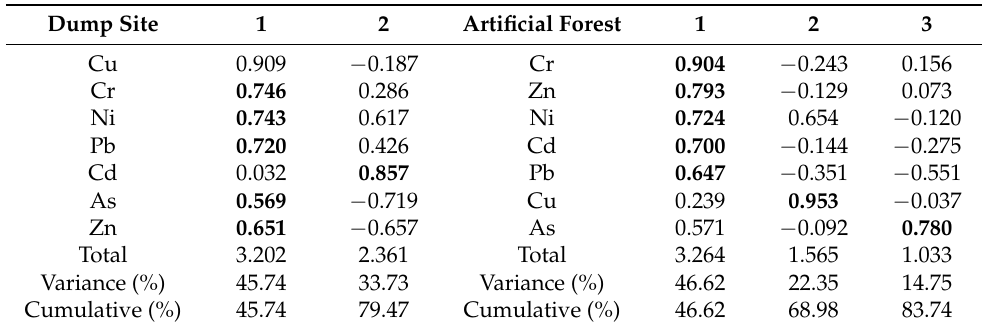
Table 6. Principal component